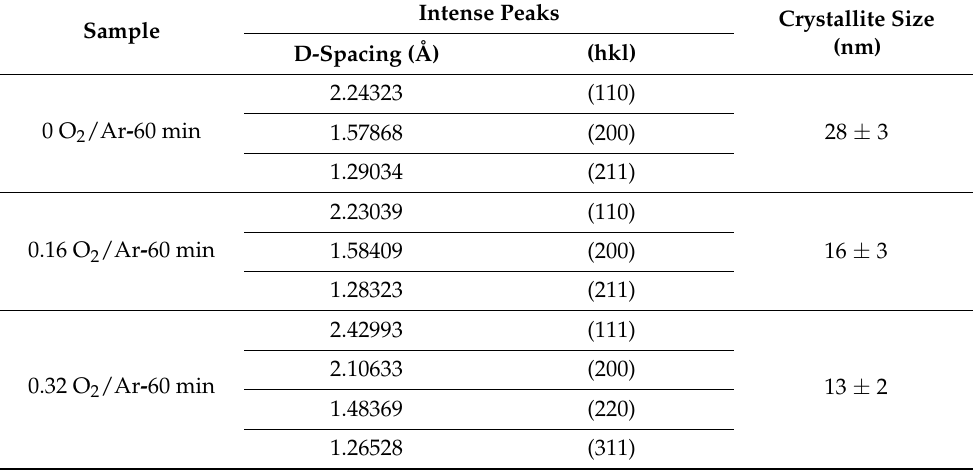
Figure 1. X-ray diffraction patterns of: ( a ) the first series of MoO x thin films prepared with different gas flow rate ratio of O 2 /Ar (all samples of the first series have metallic-like appearance); ( b ) the second series of MoO x thin films prepared with the same gas flow rate ratio of O 2 /Ar and different times of deposition (all samples have transparent appearance). Table 1. Structural parameters of crystalline MoO x films and crystallite size